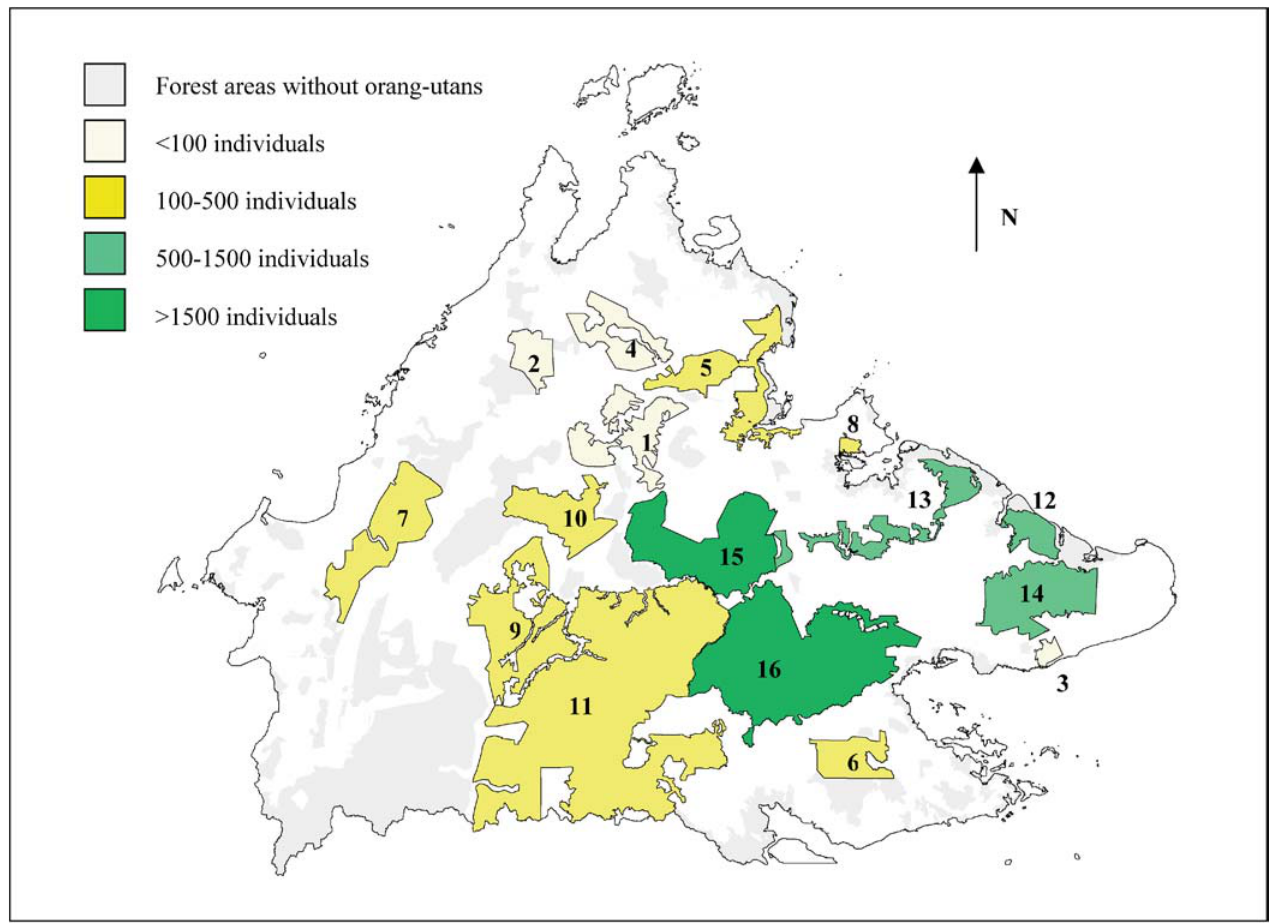
Figure 1. Distribution and Size of the 16 Major Orangutan Populations Identified during the Surveys in Sabah, Malaysia, Borneo DOI: